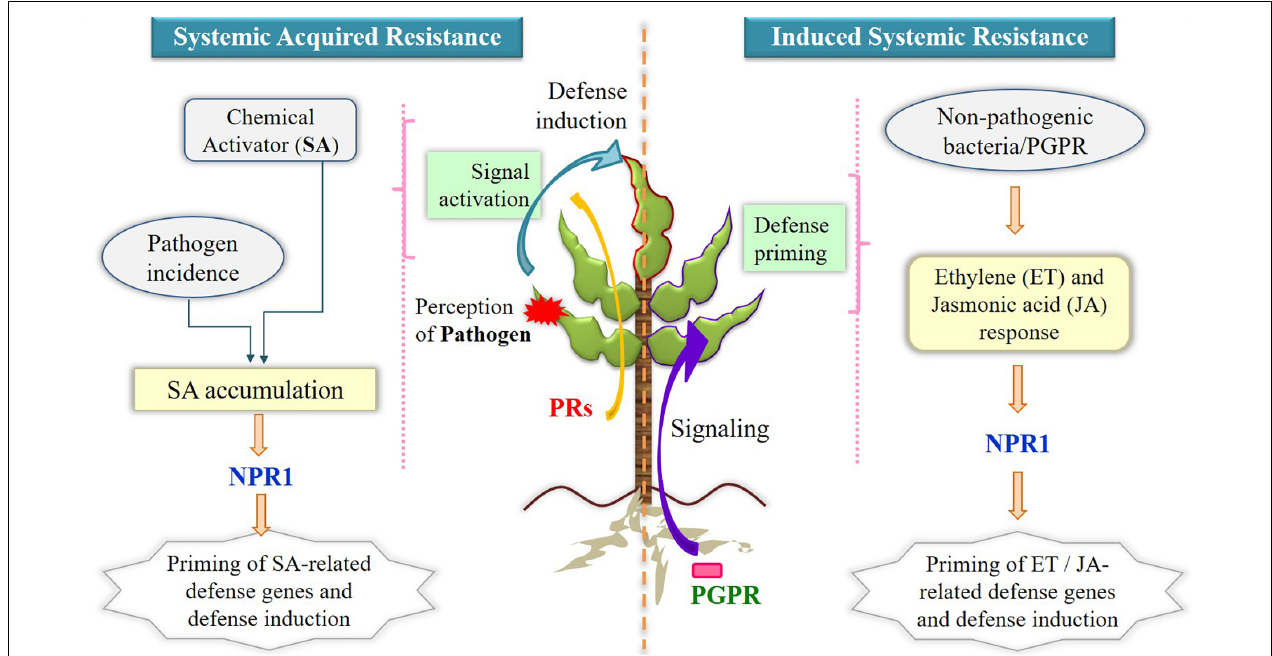
FIGURE 3 | Mechanism of SAR and ISR utilizing phytohormones for inducing defense responses upon microbial incidence. Systemic acquired resistance involves salicylic acid accumulation after perception of pathogen by plants (in red) and expression of pathogenesis-related proteins in resistant tissues (upper leaf with dark red border) for inducing defense actions, whereas in induced systemic resistance, nonpathogenic plant growth–promoting rhizobacteria enable defense responses via ethylene and jasmonic acid priming process. NPR1 is the positive regulator of salicylic acid in SAR and is also needed in downstream processes of ethylene signaling in ISR. SAR, systemic acquired resistance; ISR, induced systemic resistance; SA, salicylic acid; ET, ethylene; JA, jasmonic acid; PRs, pathogenesis related genes; PGPR, plant growth–promoting rhizobacteria; NPR1, non-expresser of PR